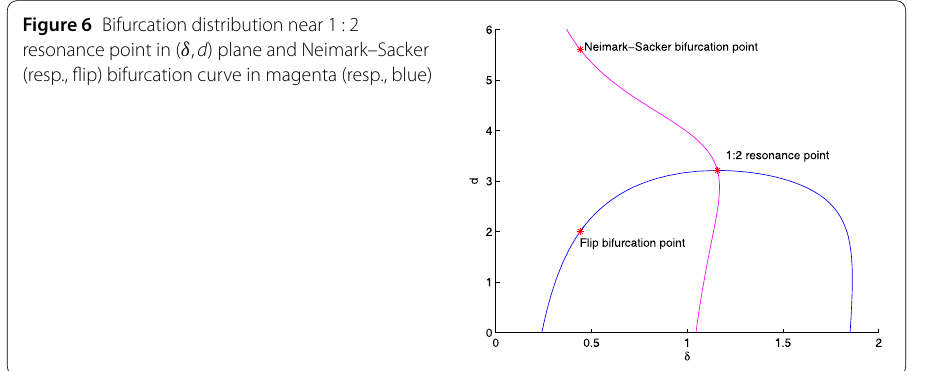
Figure 6 Bifurcation distribution near 1 : 2 resonance point in ( δ , d ) plane and Neimark–Sacker (resp., flip) bifurcation curve in magenta (resp.,